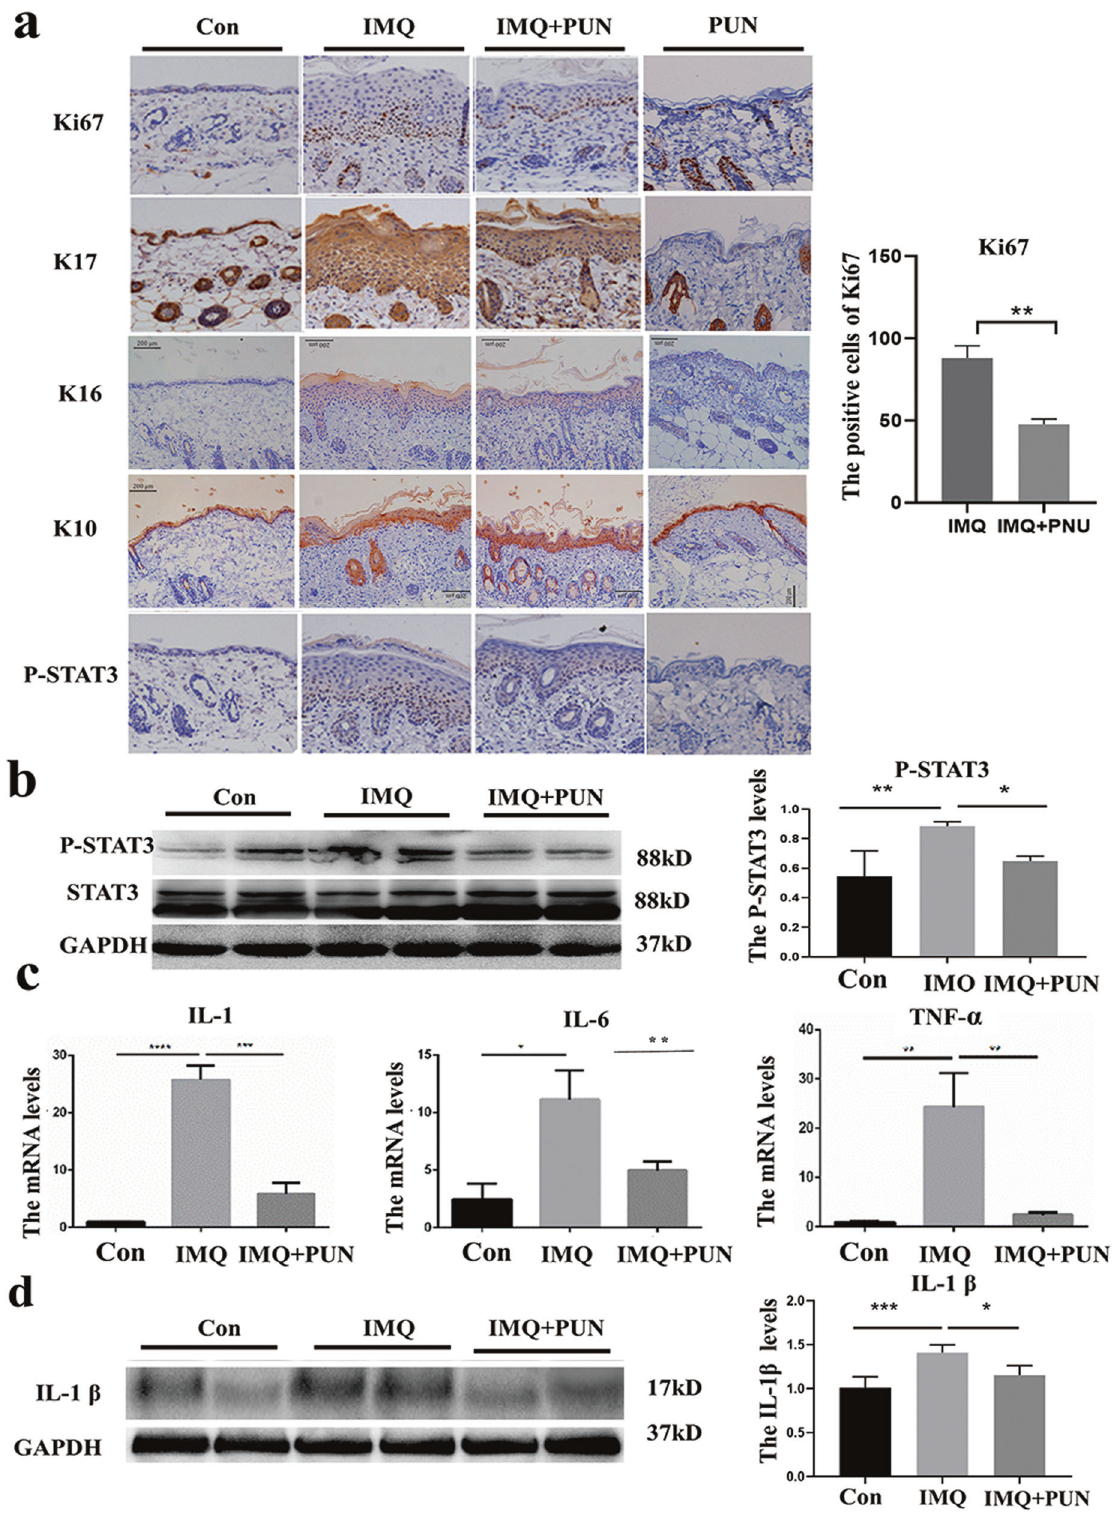
Fig. 3 PNU counteracts in fl ammatory response and abnormal differentiation of epidemical cells in vivo and in vitro. a Ki67, K17, K16, K10, and P-STAT3 immunohistochemical staining in lesion skin of IMQ-induced mice (magni fi cation × 100). b The relevant proteins of STAT3 and P-STAT3 in lesion skin were measured by western analysis. c The mRNA levels of IL-1 β , IL-6, and TNF- α in mouse skin lesions were measured by the qPCR assay. d The protein levels of IL-1 β in lesions skin were determined by western blot. The values are normalized to GAPDH. n = 6. * P < 0.05, ** P < 0.01, *** P <